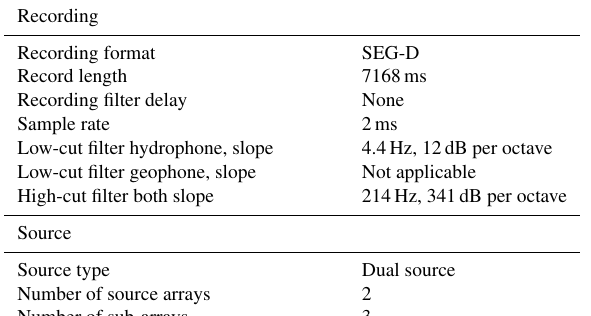
Table 1. Acquisition parameters of the seismic survey (Kramer and Heck,